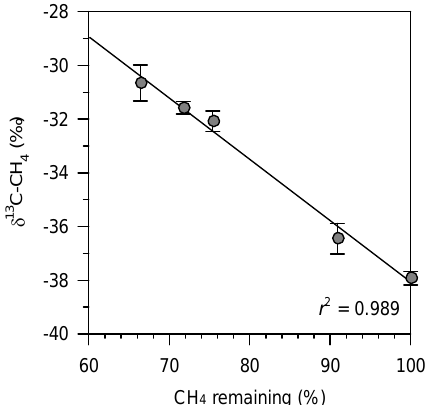
Figure 4. Example (62.5m) of relationship between the δ 13 C-CH 4 and the fraction of CH 4 remaining in the bottles during the incuba- tion (%) to determine the isotope fractionation factor carried out in September 2012 in the southern basin. Data points were gathered at a 24h interval. Symbols are the mean of duplicates; error bars rep- resent standard deviation of duplicates when higher than data point